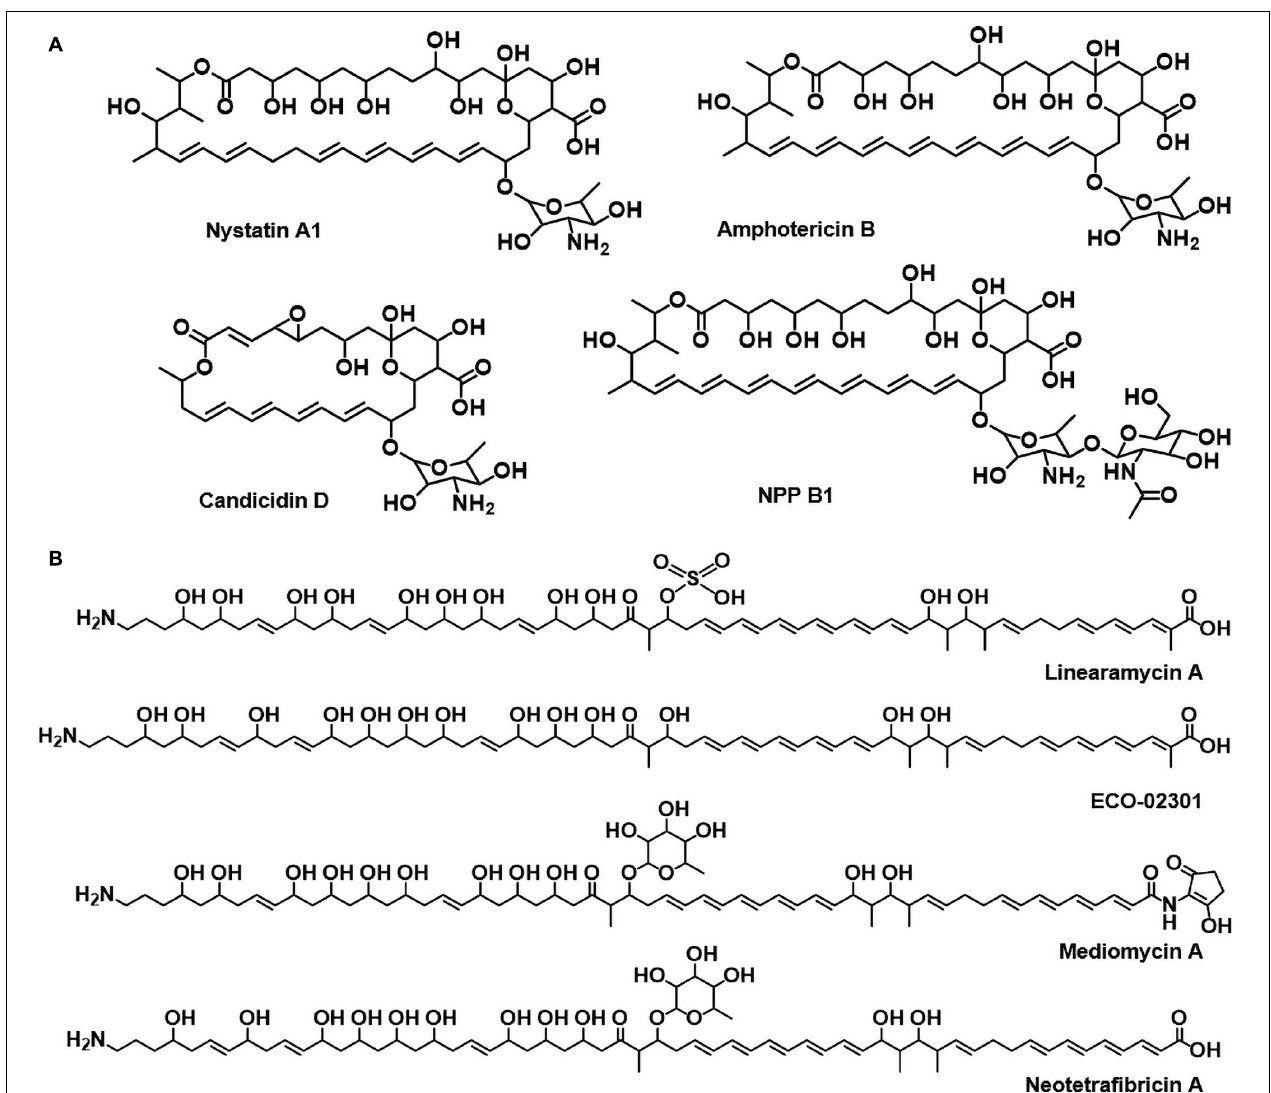
FIGURE 1 | (A) Circular polyenes; nystatin A1, amphotericin B, candicidin D, and natamycin. (B) Linear polyenes; linearmycin A, ECO-02301, mediomycin A, neotetrafibricin